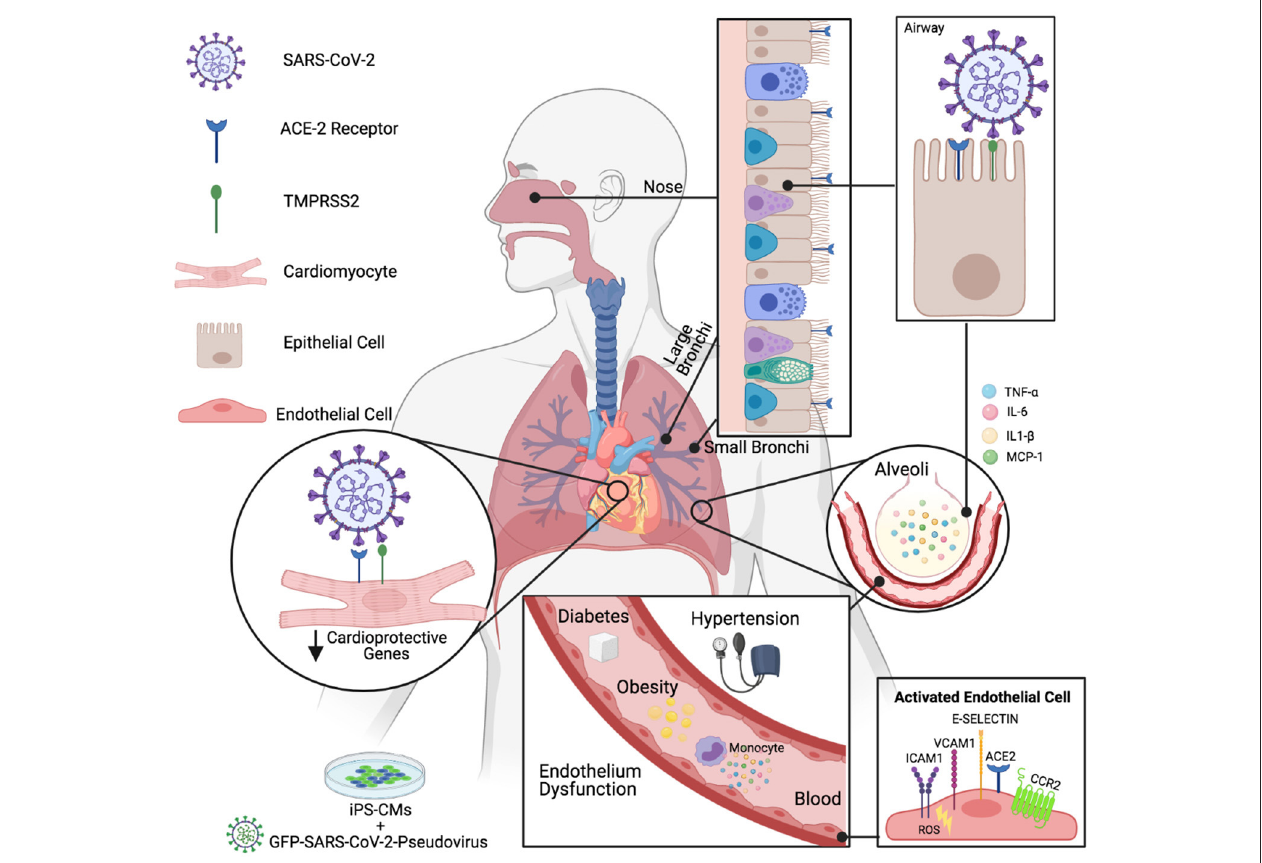
FIGURE 1 | COVID-19 on Comorbidities (created with Biorender.com). Cardiovascular injuries contribute to disease severity during SARS-CoV-2 infection. ACE2, Angiotensin-converting enzyme 2; TMPRSS2, Transmembrane serine protease 2; iPS-CMs, Human inducible pluripotent stem cell-derived cardiomyocytes; GFP-SARS-CoV-2, Green fluorescent protein bearing SARS-CoV-2 pseudovirus; TNF α , Tumor necrosis fator alfa; (IL)-6, (IL)-1 β , Interleukin; MCP-1, Monocyte chemoattractant protein 1; VCAM-1, Vascular cell adhesion molecule-1; ICAM-1, Intercellular adhesion molecule-1; CCR2, Chemokine receptor type 2; ROS, Reactive oxygen